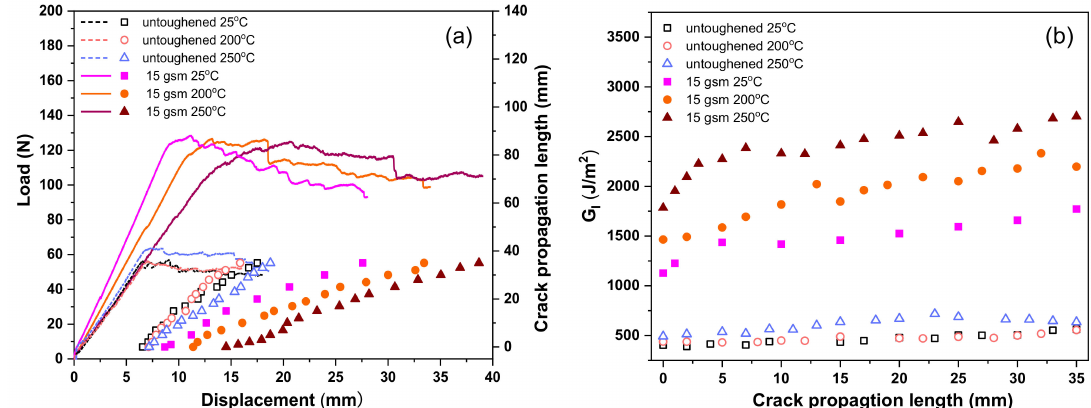
Figure 9. DCB test results of untoughened laminate and the 15 gsm fiber veils interleaved laminate measured at differ- ent temperatures: ( a ) Load–displacement curves and crack propagation length–displacement curves, as well as ( b ) the corresponding R-curves.